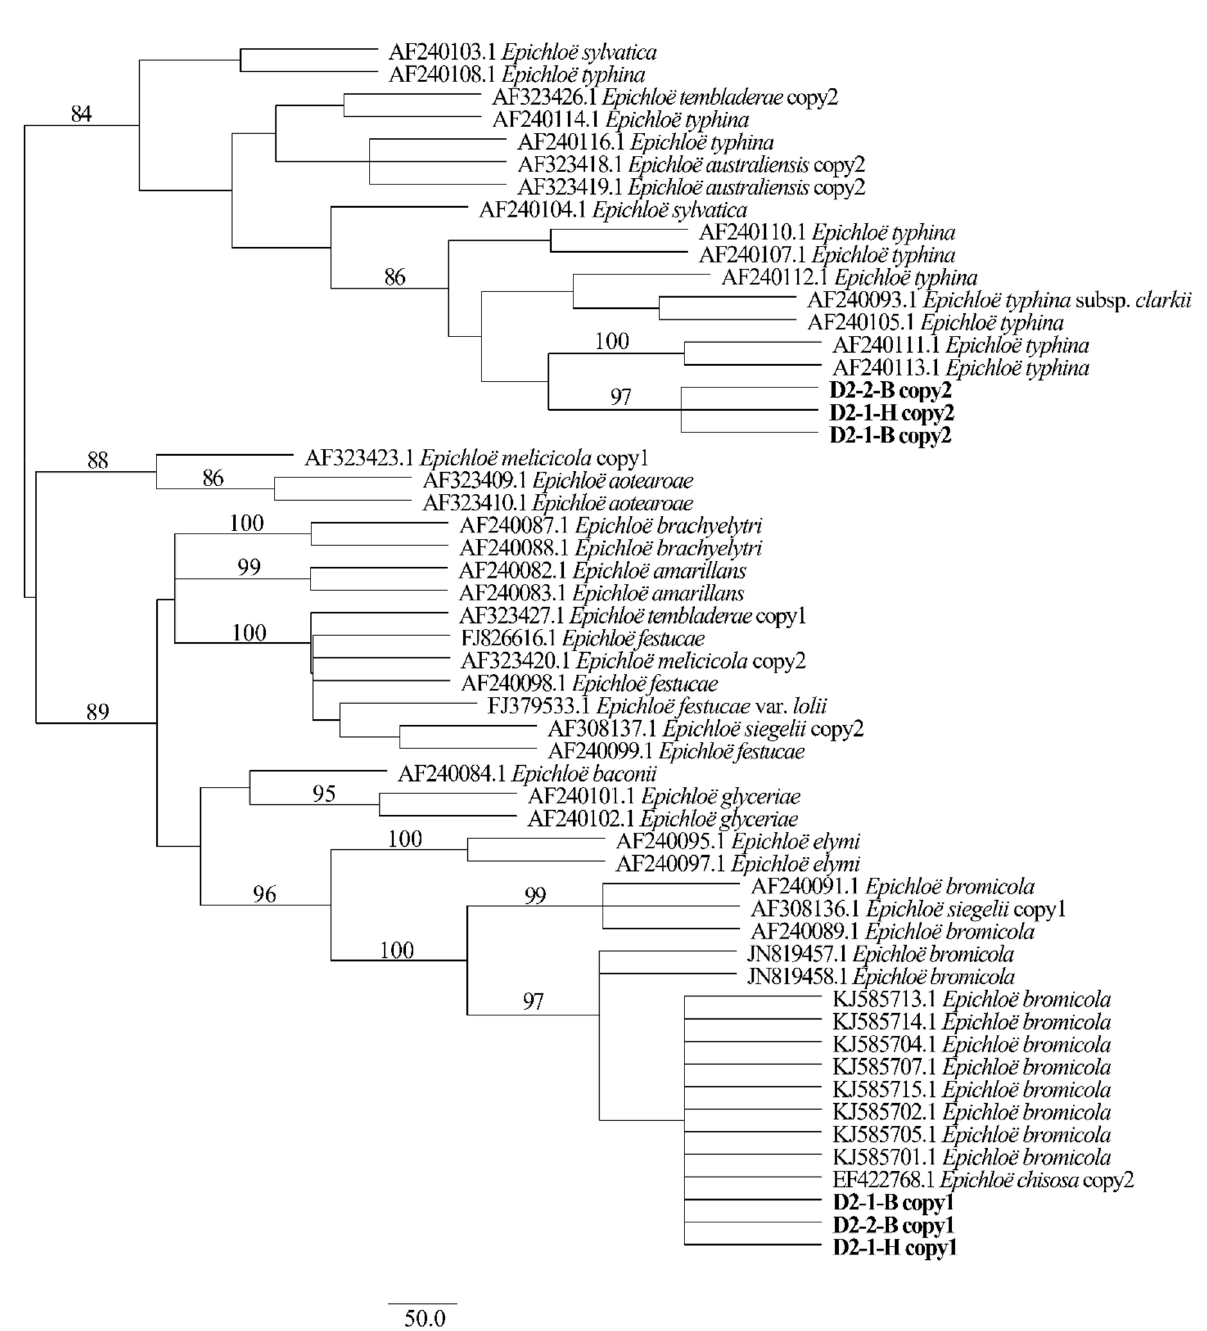
Figure 7. Phylogeny derived from maximum parsimony (MP) analysis of the actG gene from repre- sentative Epichloë species and the copies of the hybridized endophyte isolated from H. bogdanii